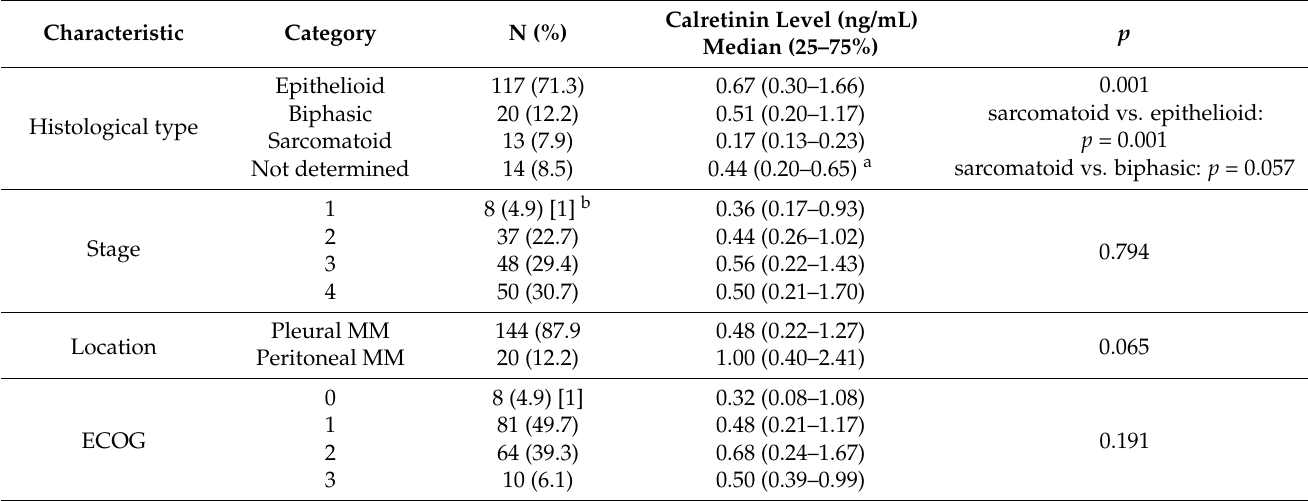
Table 2. Association of malignant mesothelioma (MM) clinical parameters with calretinin levels. Characteristic